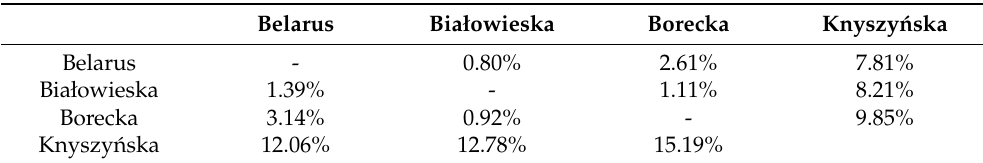
Table 5. Unbiased Nei distances among analyzed populations (below diagonal) and F st values (above